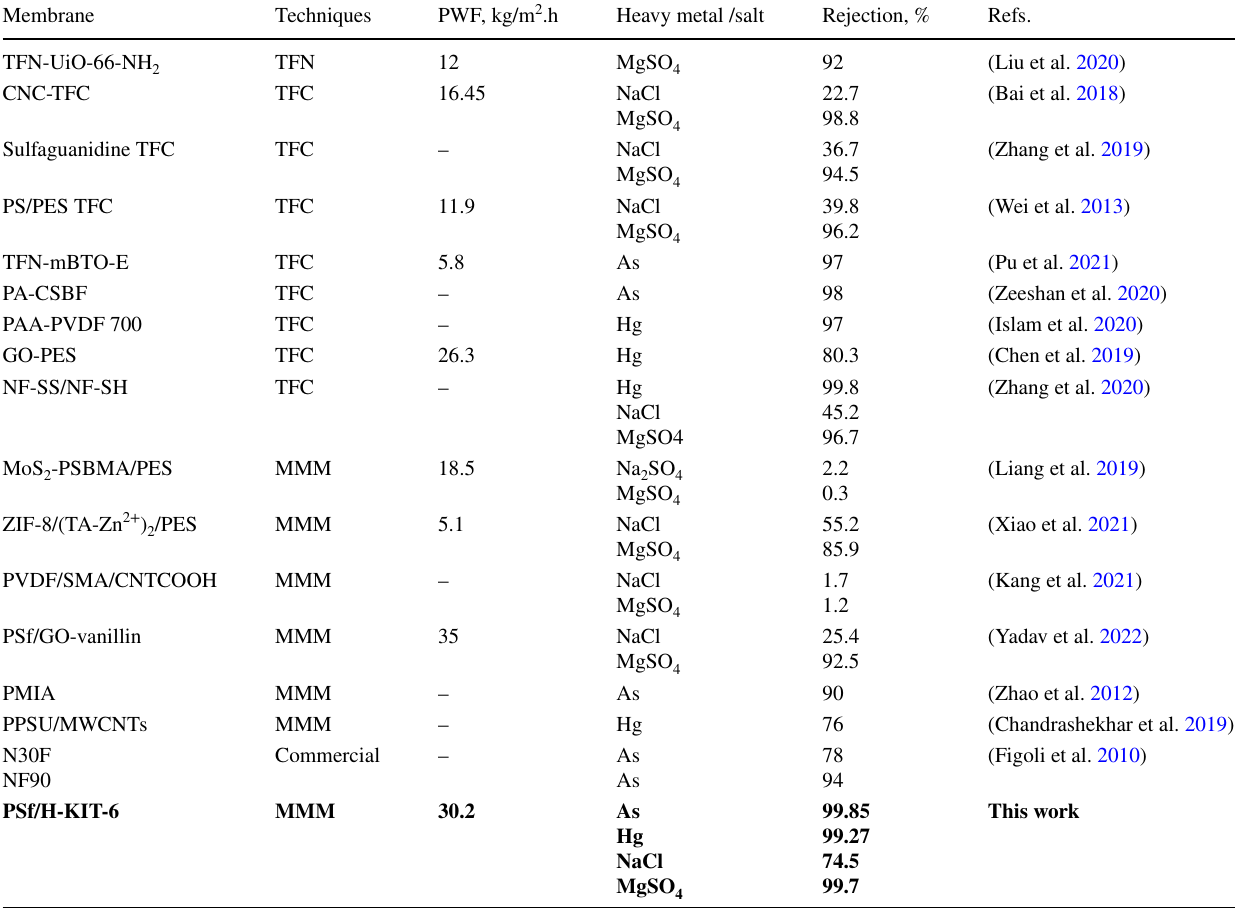
Table 6 The heavy metals/salts rejection data of some nanofiltration membranes